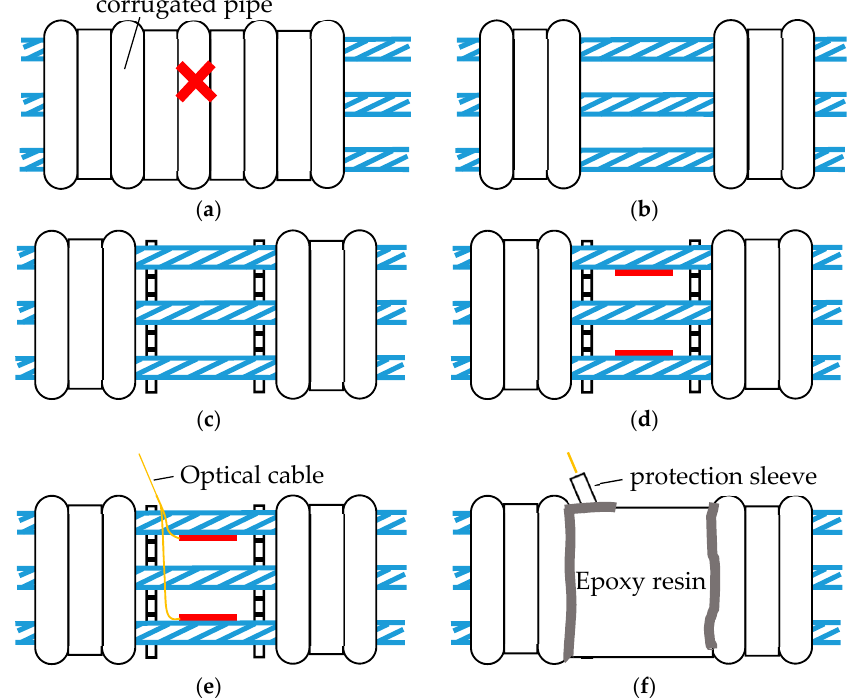
Figure 4. The installation procedure of the LFBG sensor. ( a ) Place the strands through the marked pipe; ( b ) strip the partial corrugated pipe; ( c ) install the restraining blocks; ( d ) attach the LFBG sensors; ( e ) connect the sensor to the optical cable; and ( f ) connect the protection sleeve.